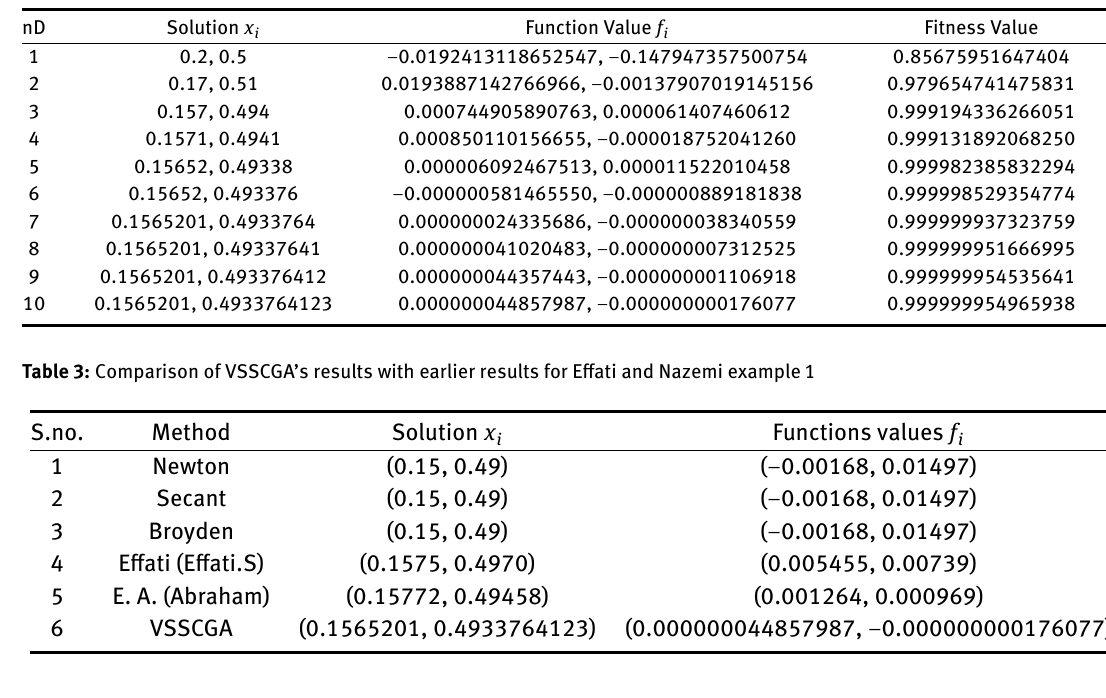
Table 2: Digit Cycle Results for Effati and Nazemi example 1